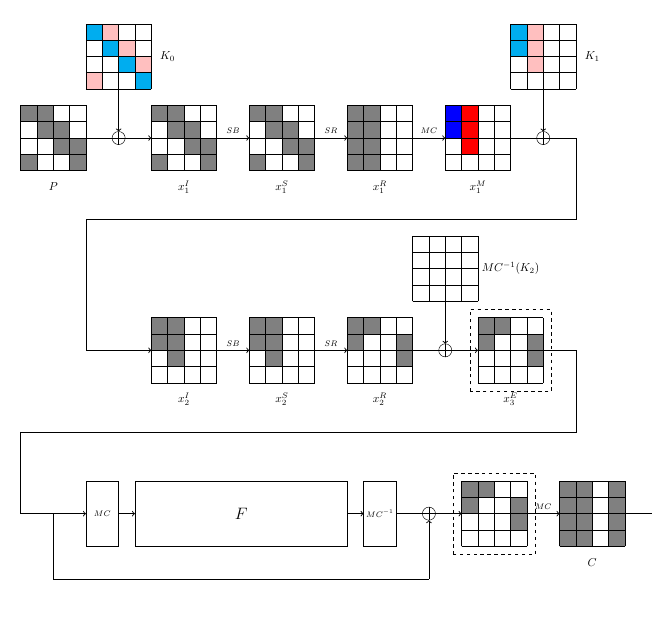
Figure 6: Analysis of AES-PRF 2 , 8